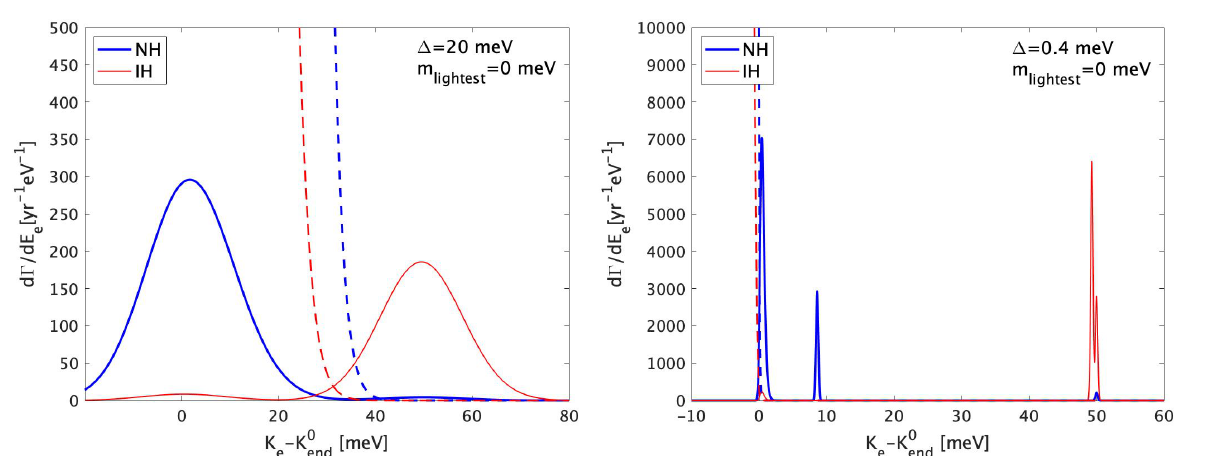
Figure 5. The expected spectra as a function of the electron kinetic energy, K e = E e − m e , for the emitted electrons from the C ν B signals (solid lines) and the β -decay background (dashed lines) in a tritium experiment, assuming m lightest = 0 meV and 100 g of tritium, with the energy resolution ∆ = 20 meV ( left panel ) and ∆ = 0.4 meV ( right panel ) in the case of Dirac neutrinos. Bold blue lines represent the NH case and fine red lines represent the IH